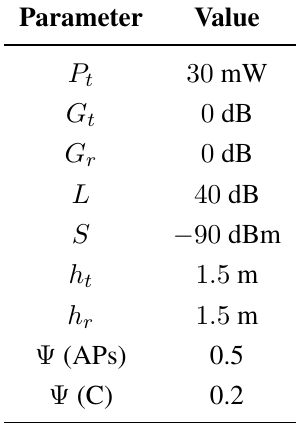
Table 2. Summary of the parameters (C,